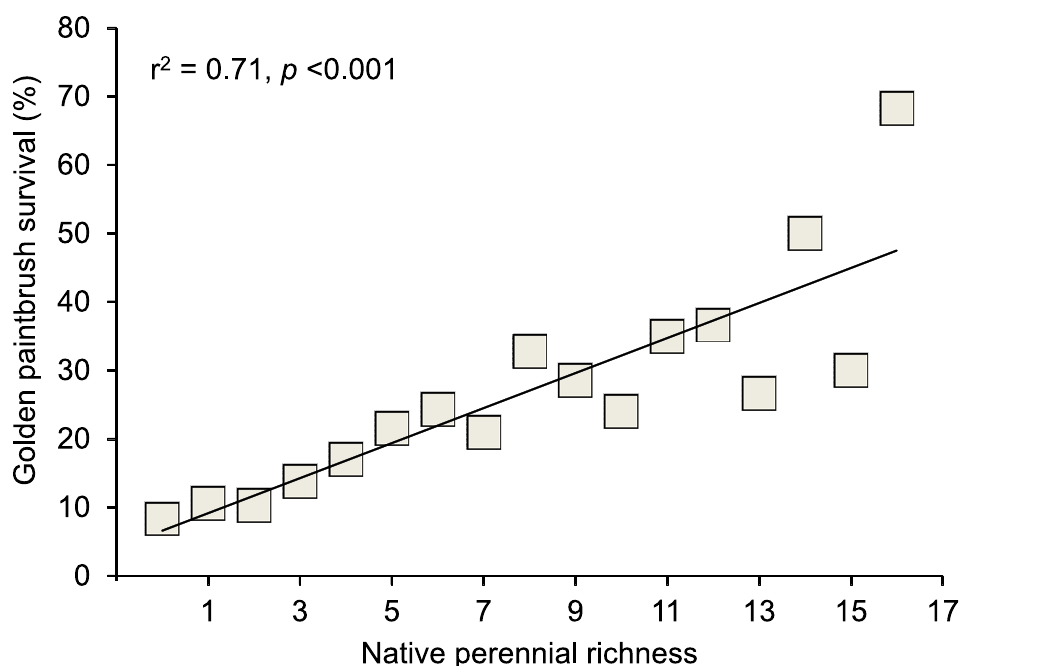
Fig 3. Native perennial richness versus survival of golden